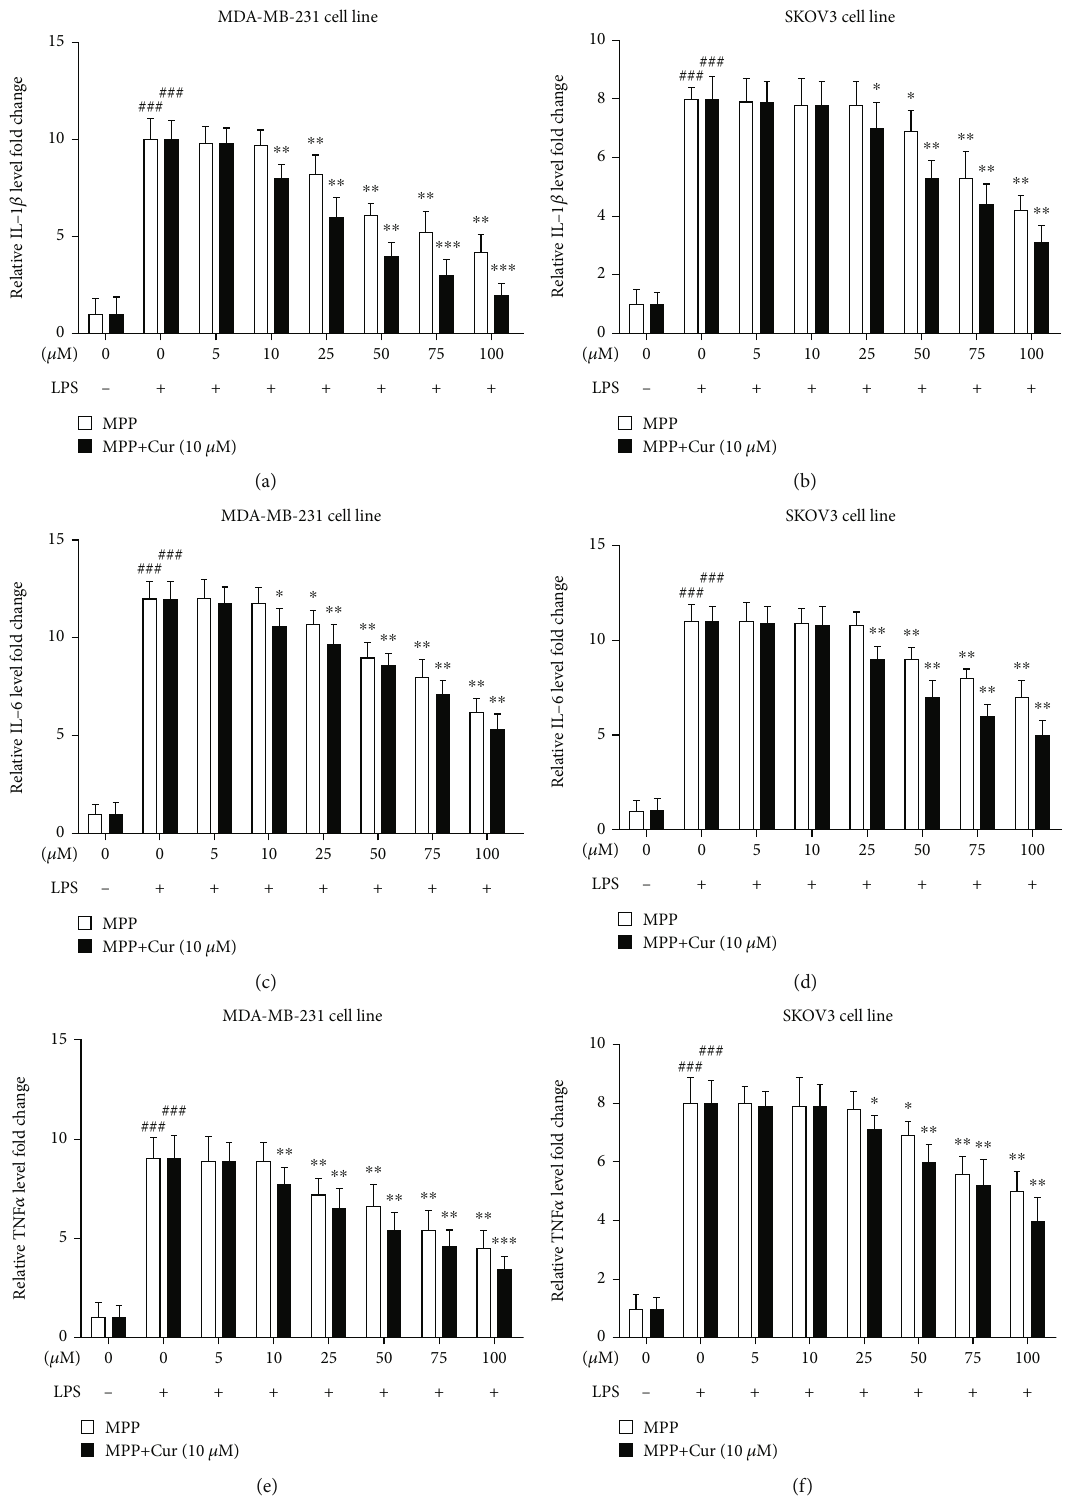
Figure 4: MDA-MB-231 breast cancer cell line and SKOV3 ovarian cancer cell line were treated with LPS to induce in fl ammation